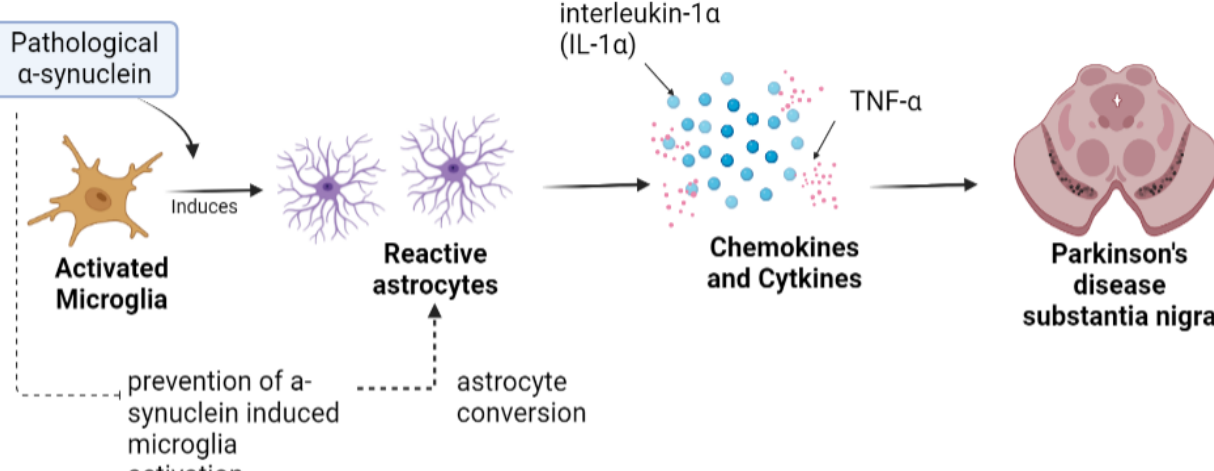
Figure 2. Astrocytes in Parkinson’s disease. Toxic alpha-synuclein convert resting astrocytes into reactive astrocyte, which further disrupts balance of cytokines that can possibly result in loss of DA neurons.